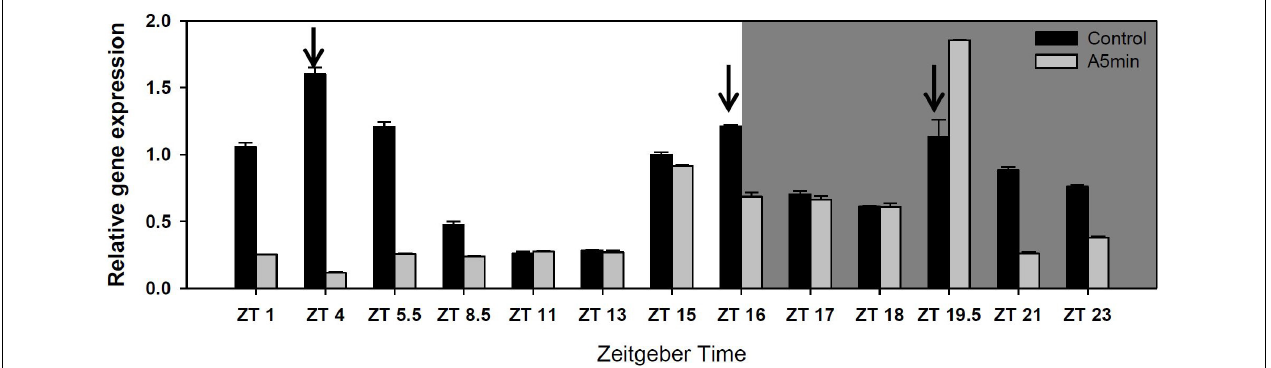
FIGURE 1 | Gene expression of cryptochrome 2 over 24 h in a day-night cycle of 16:8 h (control) and in ALAN (A5 min: 5 min light every hour of the night; N = 3, mean + SD). Shaded area: night, white area: day. Arrows indicate the highest peaks of gene expression in the control treatment.